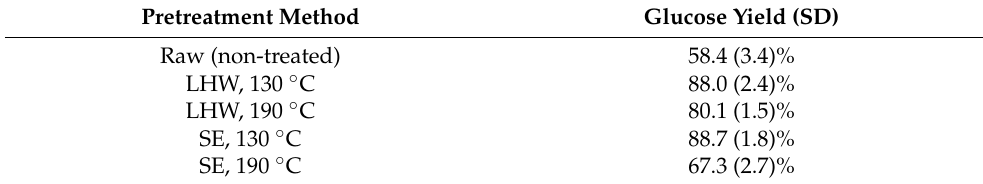
Table 3. Cellulose to glucose hydrolysis